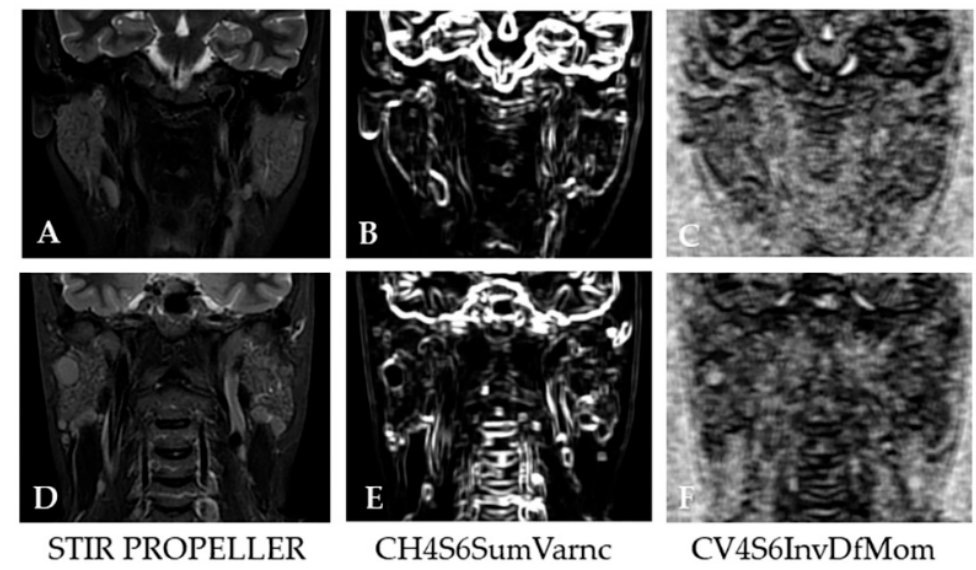
Figure 5. Texture maps presenting the distribution of the independent features (CH4S6SumVarnc, CV4S6InvDfMom) associated with NHL development in PG of patients with pSS on the selected MRI coronal STIR PROPELLER image. ( A – C ) images of a patient with pSS and without lymphomatous proliferation in the parotid gland; ( D – F ) images of a patient with pSS and NHL development in the right parotid gland.